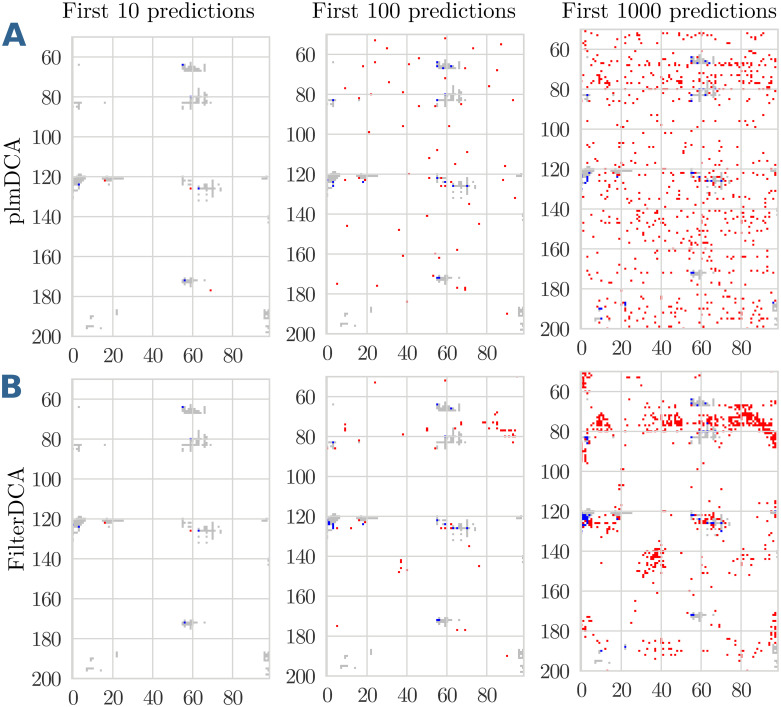
Contact map prediction for the interaction between the domain families PF01557 and PF09298 co-occurring in Fumarylacetoacetate (FAA) hydrolases.The upper panels (A) show the predictions of plmDCA, the lower panels (B) those of FilterDCA, for the first 10, 100 or 1000 predicted contacts. In each figure, the native contacts are shown in grey, TP predictions of the two methods in blue, FP predictions in red. This example shows a case where the plmDCA signal is weak, and consequently cleaning by FilterDCA does lead to a marginal improvement only.